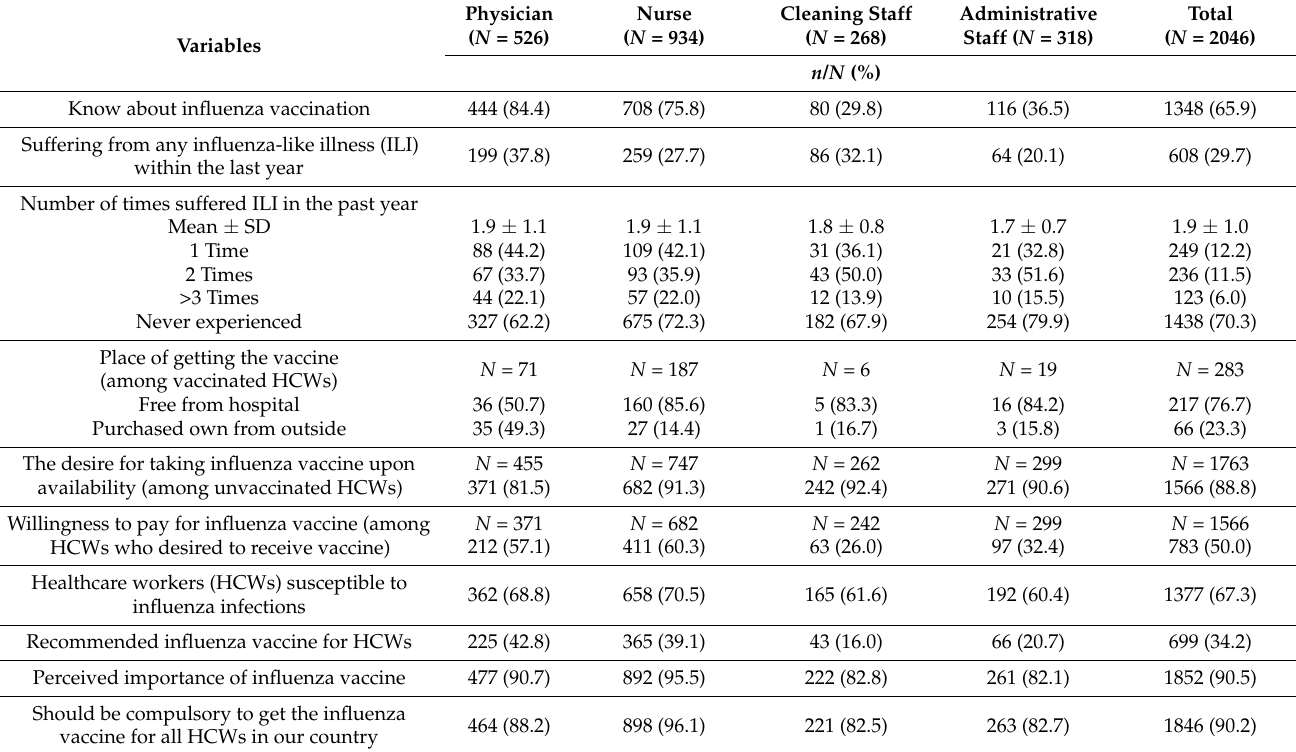
Table 2. Perception and practices regarding influenza vaccination among healthcare